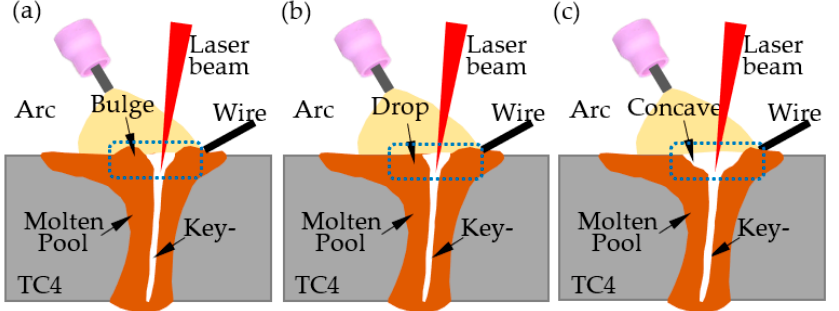
Figure 19. Schematic diagram of the molten pool flow process near the laser beam: ( a ) bulge; ( b ) drop; ( c )